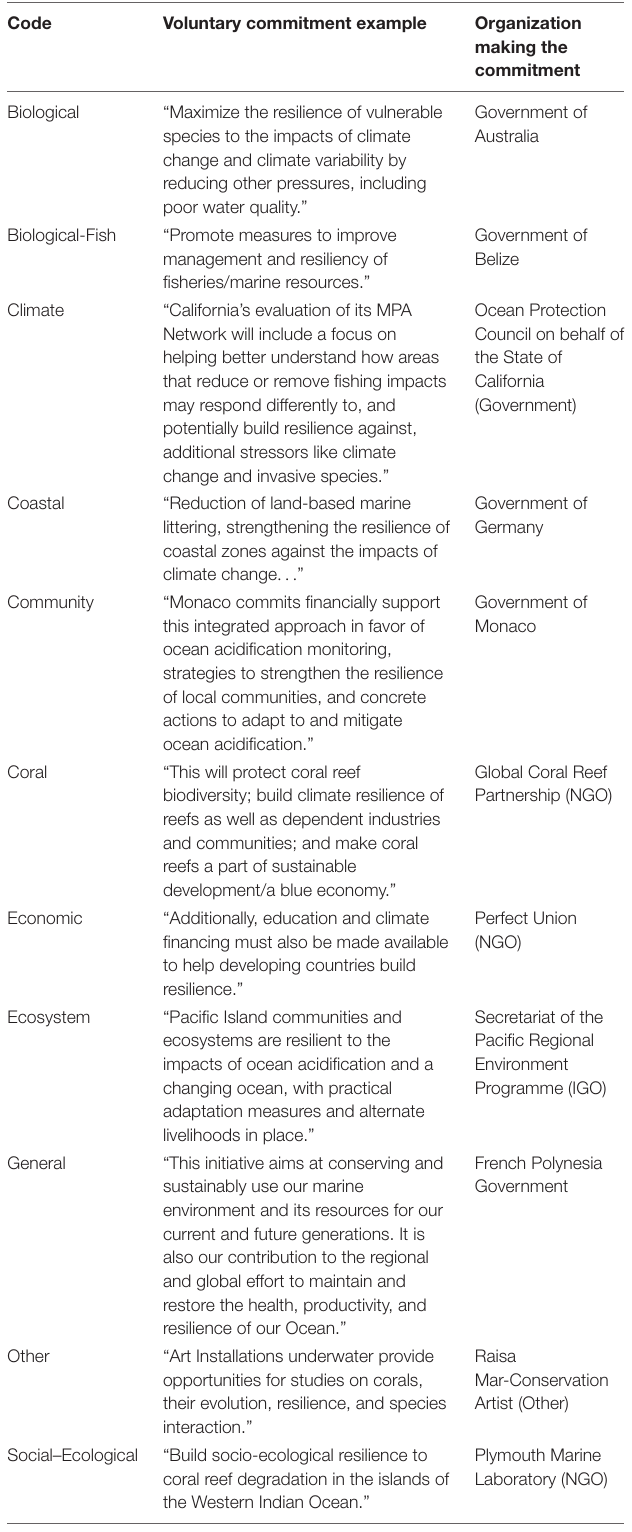
TABLE 3 | Examples of resilience